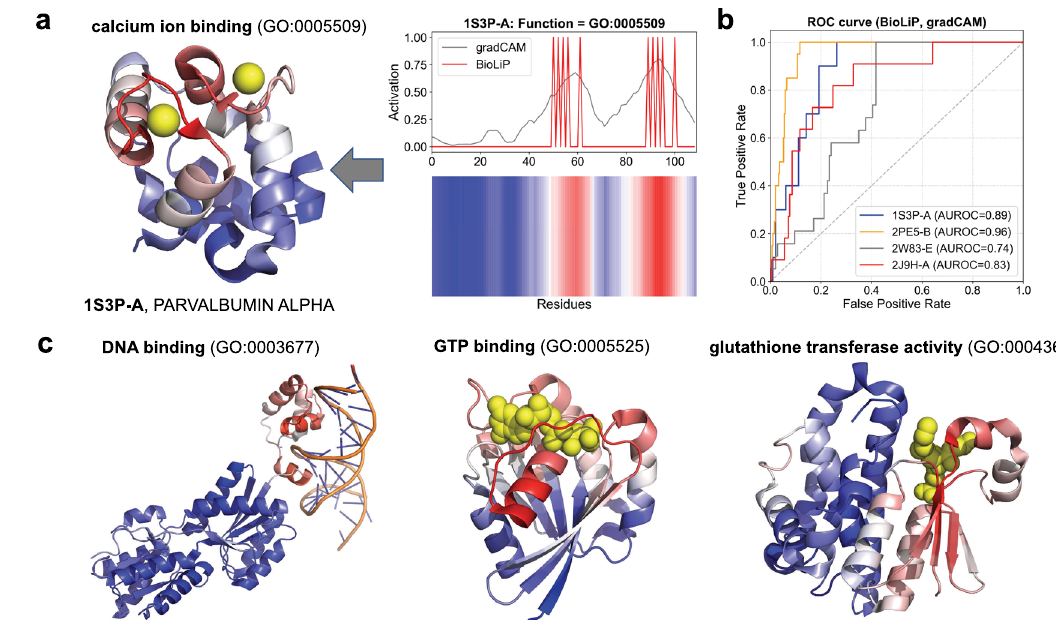
Fig. 4 Automatic mapping of function prediction to sites on protein structures. a An example of the gradient-weighted class activation map for ‘ Ca Ion Binding ’ (right) mapped onto the 3D structure of rat α -parvalbumin (PDB Id: 1S3P), chain A (left), annotated with calcium ion binding. The two highest peaks in the grad-CAM activation pro fi le correspond to calcium-binding residues. b ROC curves showing the overlap between grad-CAM activation pro fi les and binding sites, retrieved from the BioLiP database, computed for the PDB chains shown in panel ( c ). c Examples of other PDB chains annotated with DNA binding, GTP binding, and glutathione transferase activity. All residues are colored using a gradient color scheme matching the grad-CAM activity pro fi le, with more salient residues highlighted in red and less salient residues highlighted in blue. No information about co-factors, active sites, or site- speci fi city was used during training of the